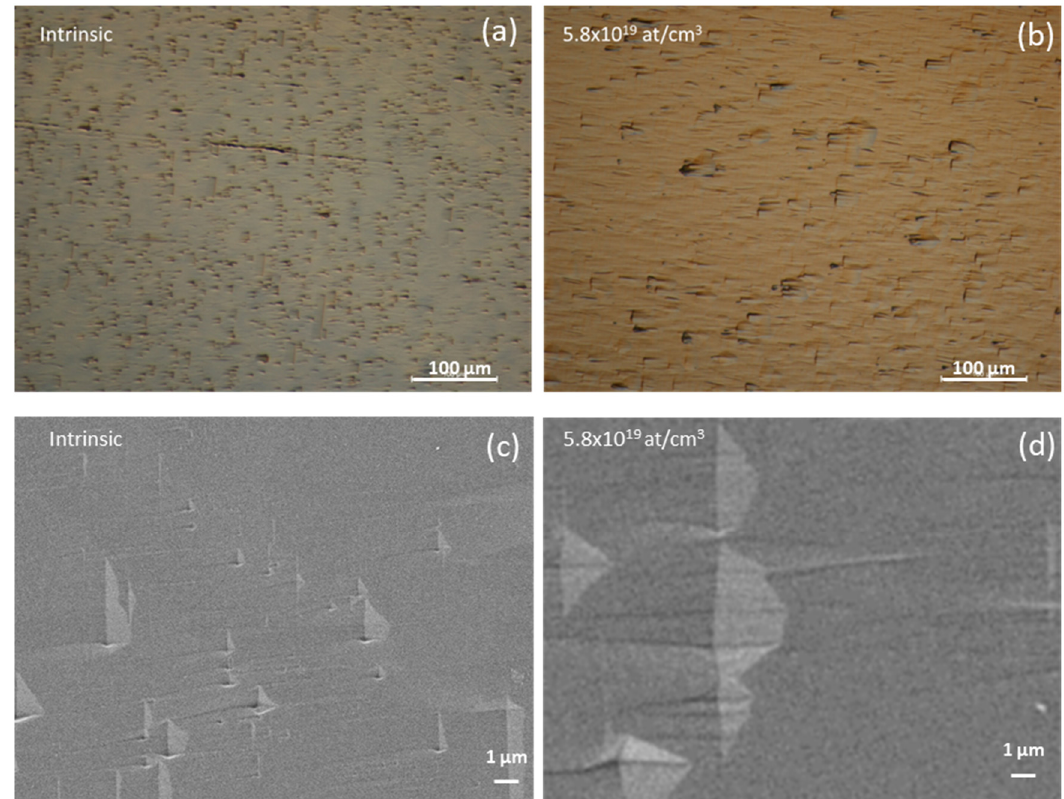
Figure 3. Optical and SEM images of the intrinsic ( a , c ) and N-type doped ( b , d ) samples subjected to selective KOH etching.